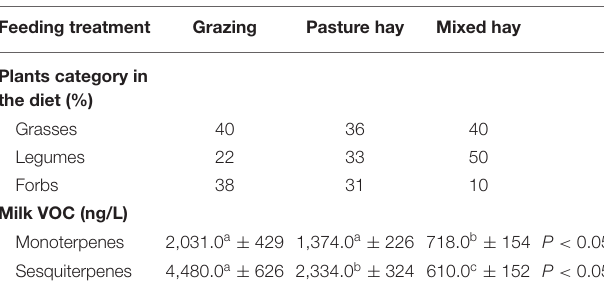
TABLE 1 | Monoterpenes and sesquiterpenes content (mean ± SEM) in milk from three feeding systems [from (34)]. Feeding treatment Grazing Pasture hay Mixed hay Plants category in the diet (%) Grasses 40 36